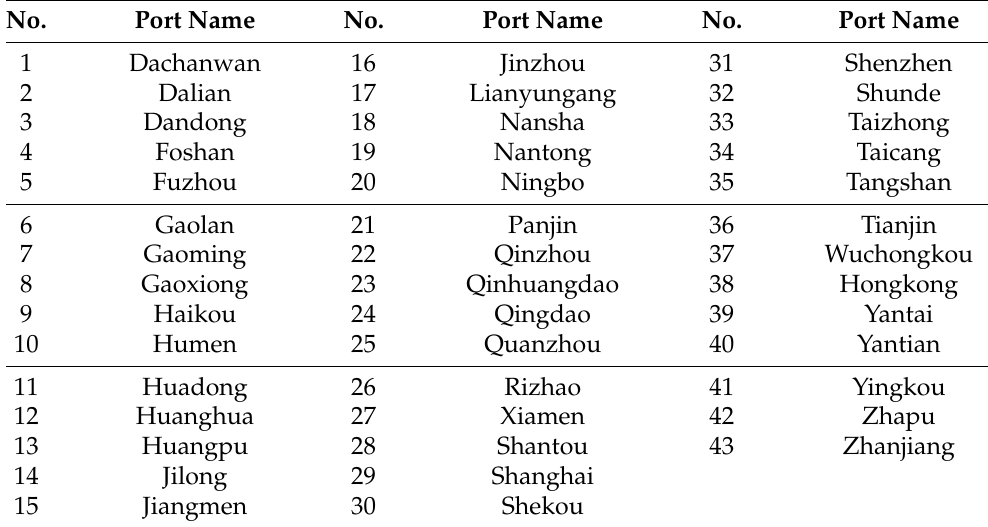
Table A1. Ports considered in this case study.